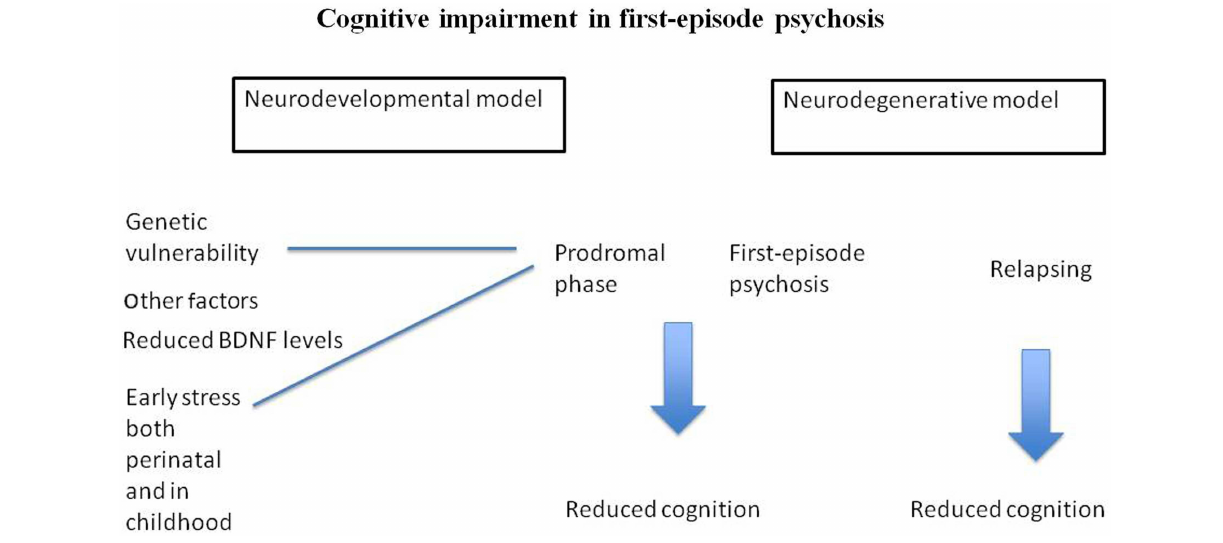
FIGURE 1 | Suggests that cognitive impairment in FEP is related to neurodevelopmental abnormalities. Figure 1 also postulate that stress, as well as genetic vulnerability may be part of the complex etiology behind cognitive impairment in psychosis.